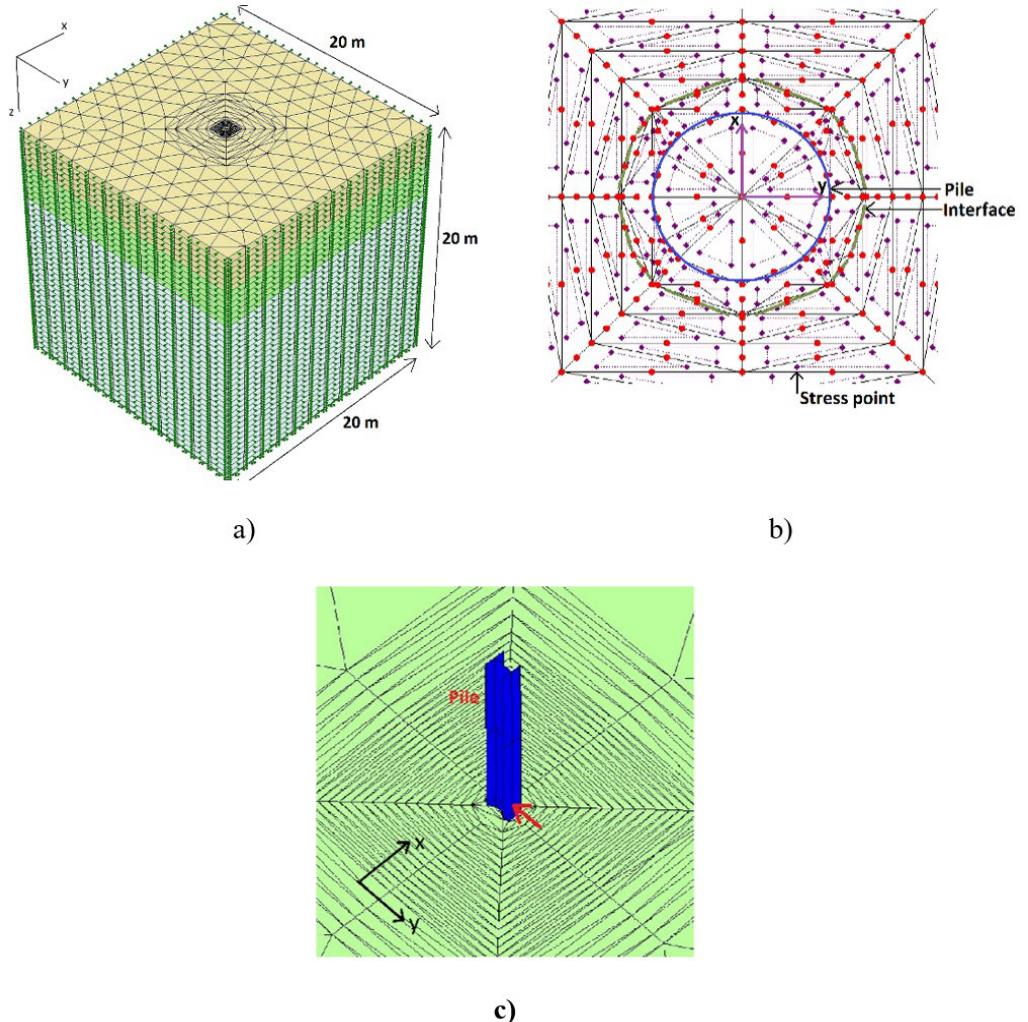
Figure 7. Three-dimensional finite-element mesh: (a) 3D view of CFA pile model; (b) cross-section in x-y plane of CFA pile model; (c) surface view of steel H-section HS1 pile